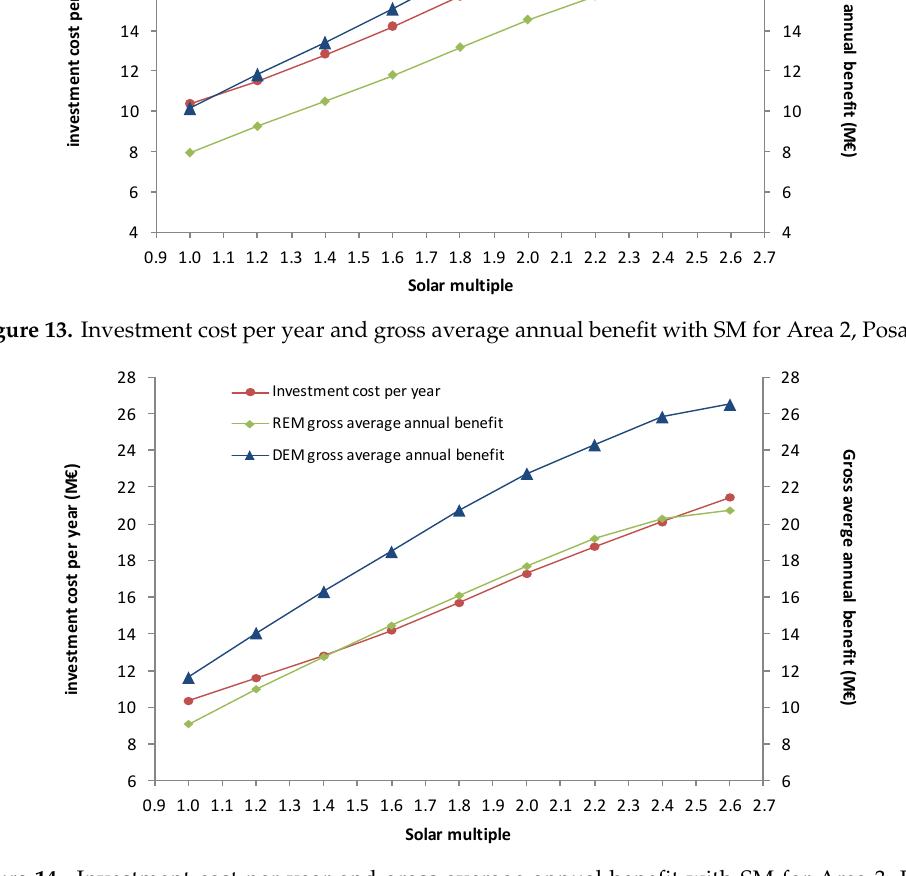
Figure 14. Investment cost per year and gross average annual benefit with SM for Area 3, Death Valley, CA. Table 9. Optimal economic results in a DEM for a 100 MW e PT power plant with two-tank molten-salt TES.